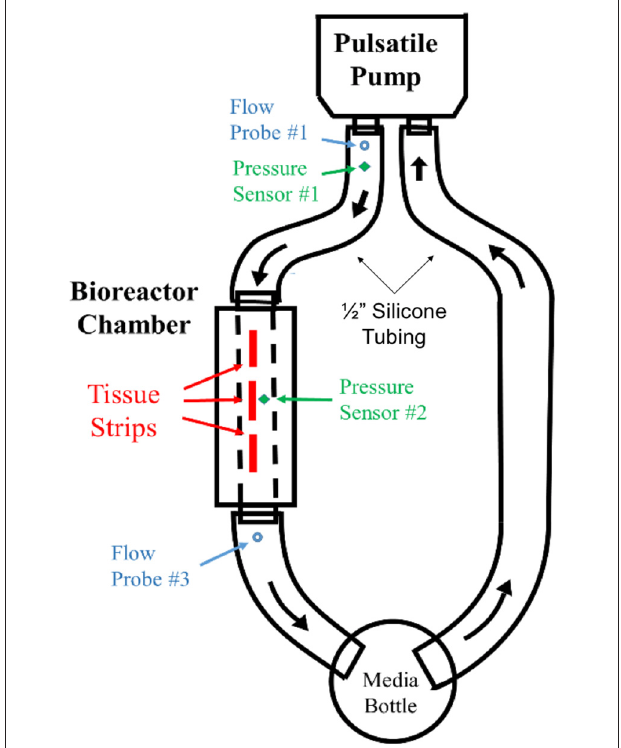
FIGURE 4 | Flow diagram for FSF bioreactor dynamic conditioning system. Pressure and flow sensors at pump outlet (V1, P1) and at a pressure sensor at bioreactor chamber (P2) were used to validate flow velocities within the bioreactor